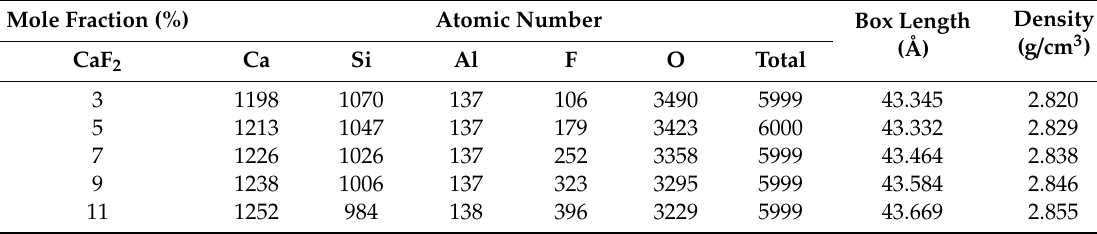
Table 3. Simulated atomic number and box length of slags at 1673 K.